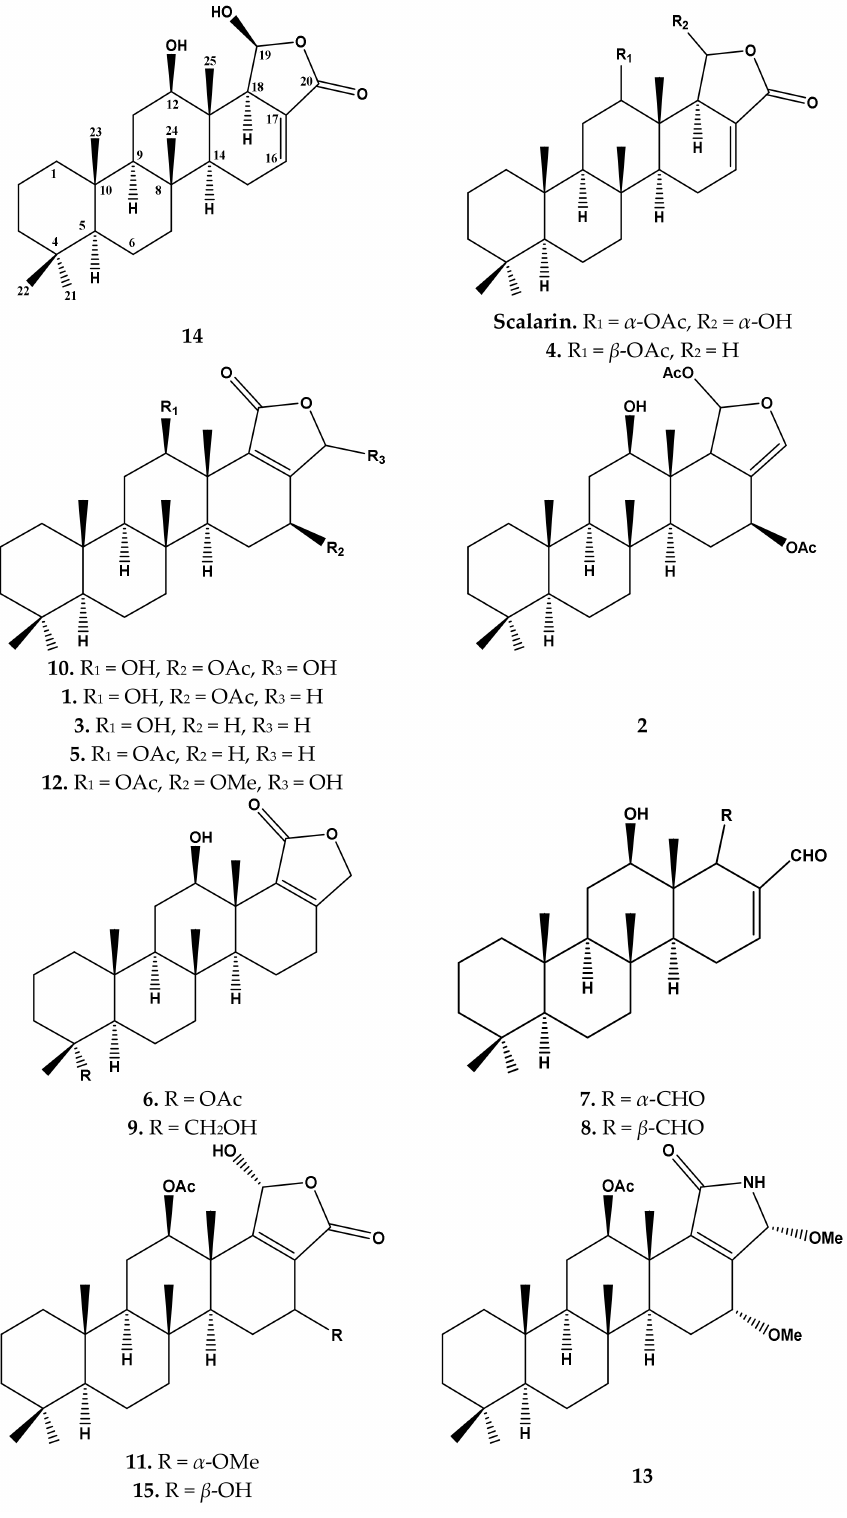
Figure 2. Scalarane Sesterterpenes 1 – 15